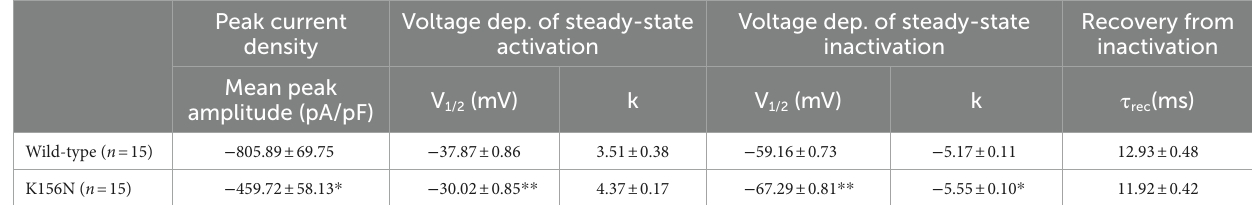
TABLE 1 Biophysical parameters of Na v 1.2 wild-type and K156N